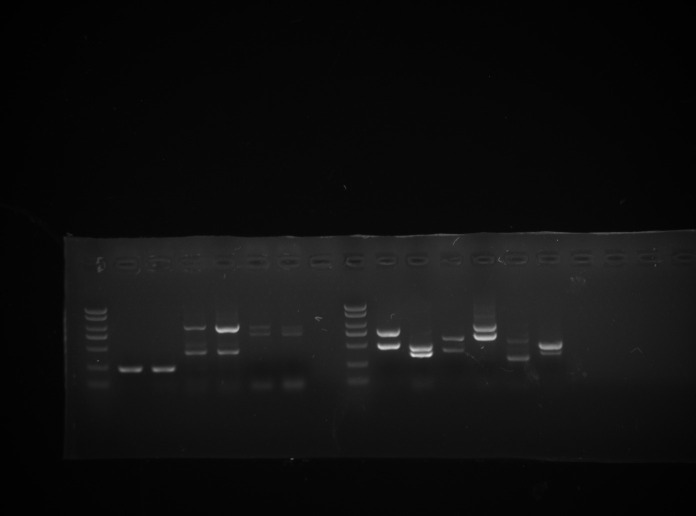
Validation of AS events in the poplar leaves.PCR results of six poplar AS genes by 1% (w/v) gel electrophoresis. 1: DL 2000 marker, 2: gene 1775, 3: gene 2340, 4: gene 14298, 5: gene 15649, 6: gene 5375, 7: gene 6835.